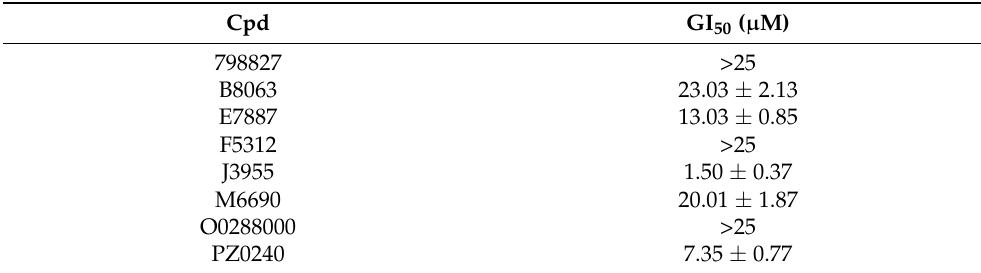
Table 4. The antiproliferative activity of the selected compounds at 48 h against HepG2 cell lines expressed as GI 50 values (GI 50 ± SE ( µ